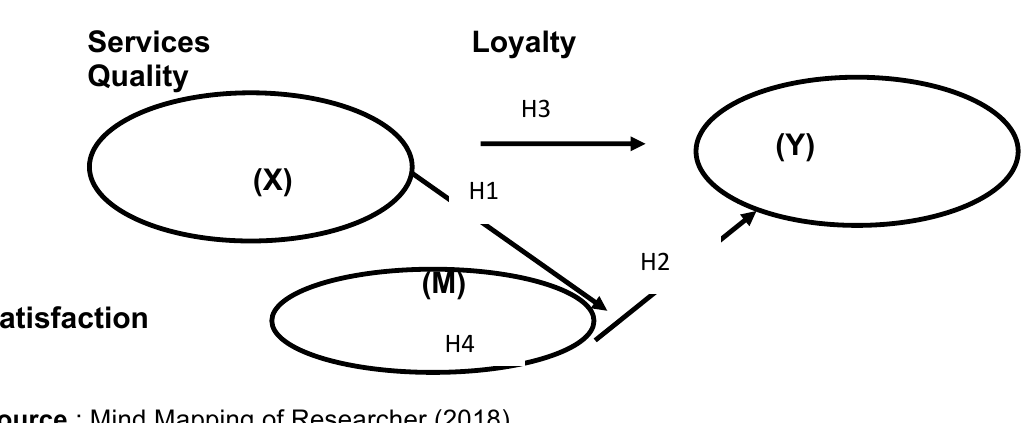
Figure 1: Research Design of The Role of Satisfaction in Mediating the Effect of Services Quality on the Customers’ Loyalty in the Village Credit Institution of Pekraman,